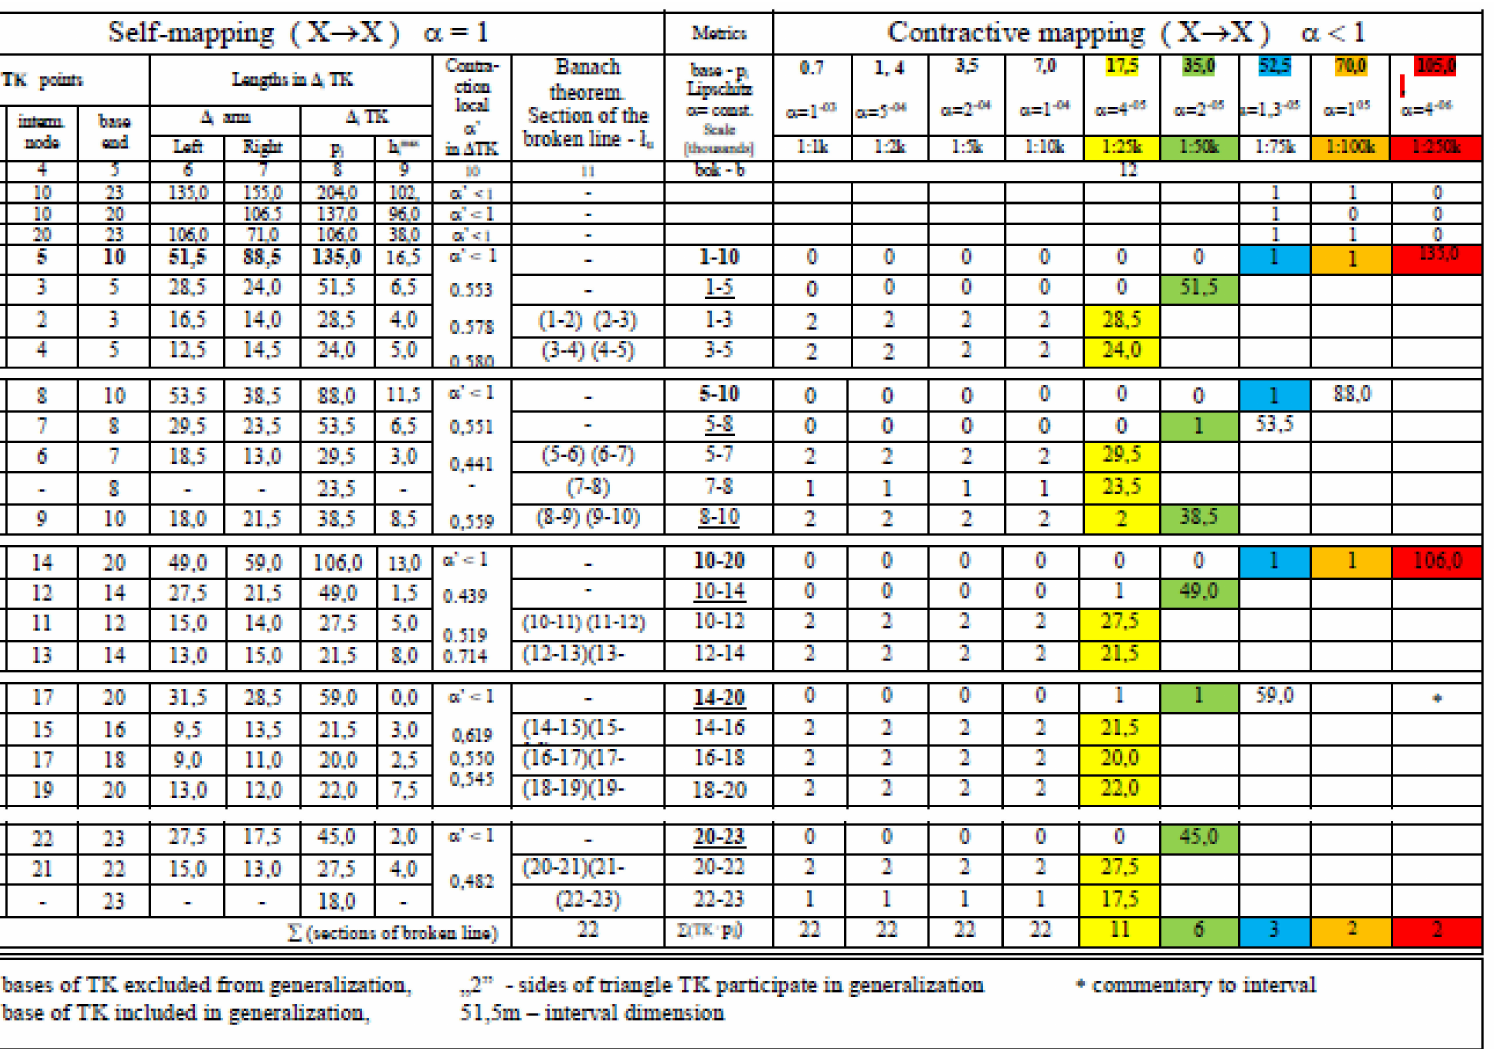
Figure A8. Analysis of polyline (broken line) l u data generalisation by contractive mappings X → X